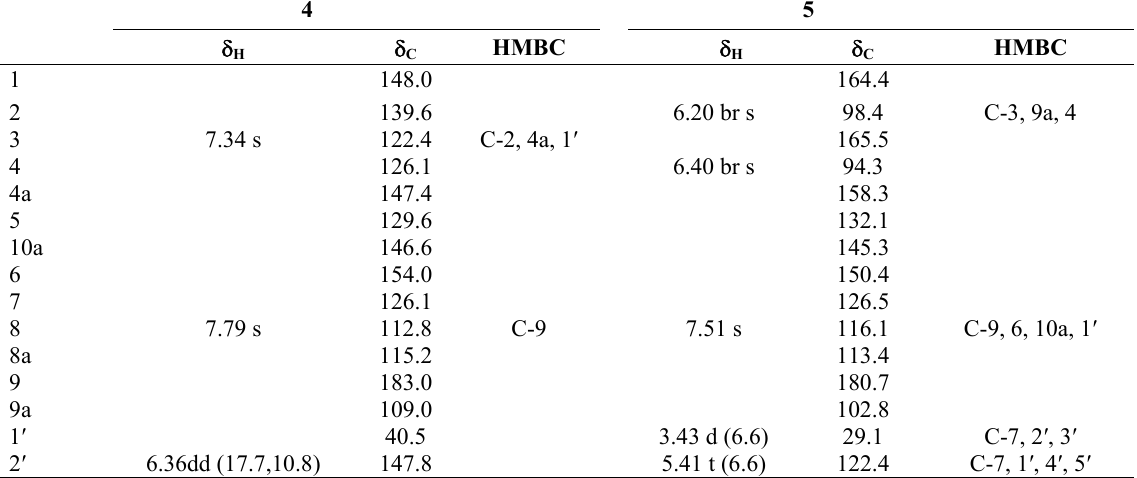
Table 3. 1 H- and 13 C-NMR, HMBC data of compounds 4 - 5 in acetone-d